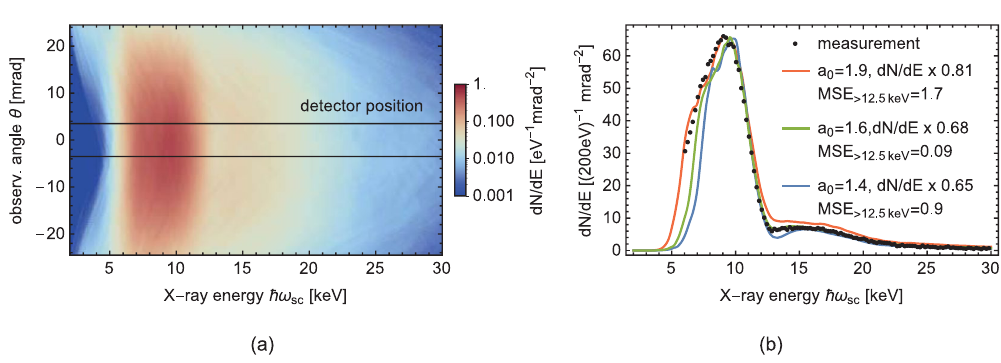
Figure 4. Comparison of measurement data with clara2 simulation for the a 0 = 1.6 measurement. ( a ) Simulated ICS spectra in the 1/ γ cone along the laser polarization plane (logarithmic color scale). The box indicates the detector position, for which the on-axis spectrum in ( b ) is integrated. ( b ) Comparison of the measured on-axis spectrum (black dots) with simulated spectra (solid lines). The green line shows a simulation, which matches the measurement well in shape of the second harmonic and its flux ratio to the fundamental. In red (blue), a spectrum with too high (low) laser intensity indicates the sensitivity of the second harmonic to this parameter. The mean square error (MSE) for energies above 12.5 keV is listed as an indicator for the goodness of the fit. From the comparison, the refined laser parameter for this measurement are determined as a 0 = 1.6 (2.25 J and 35